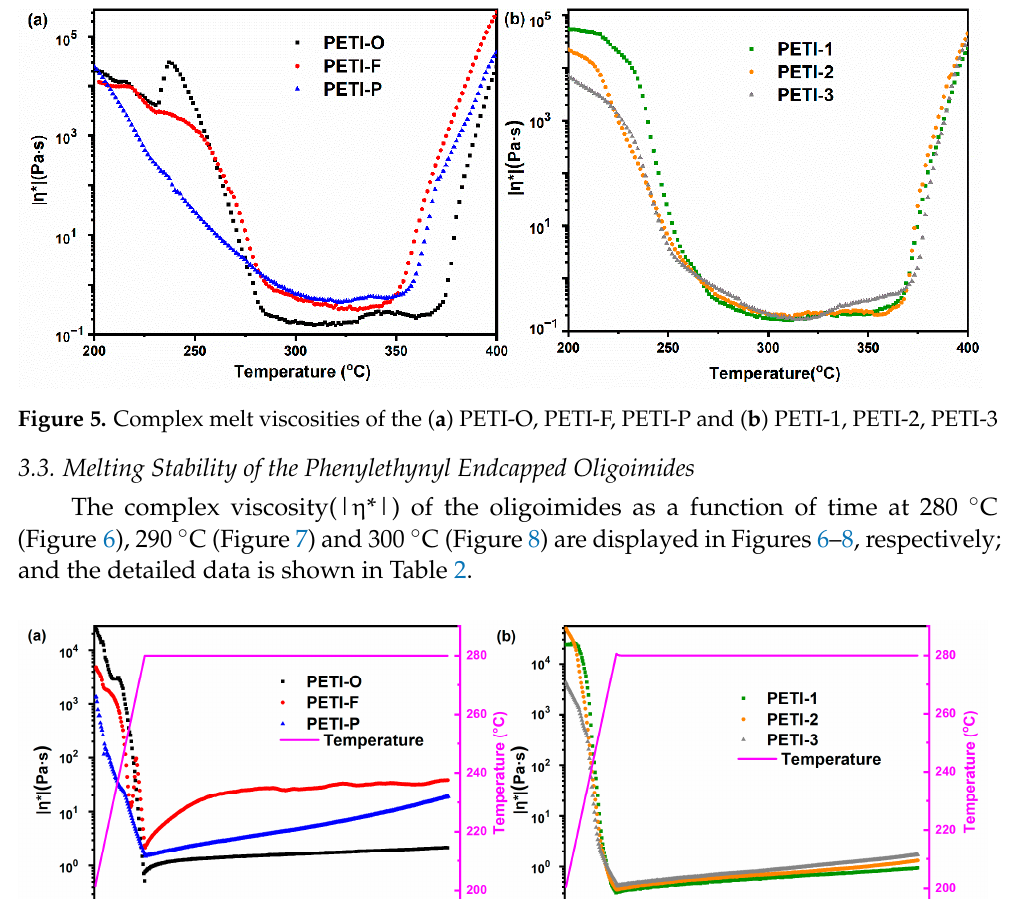
11 of 24 Figure 4. Wide angle X-ray diffraction patterns of ( a ) PETI-O, PETI-F, PETI-P and ( b ) PETI-1, PETI-2, PETI-3. In order to investigate the melting flowing ability of the PEPA end-capped oli- goimides, rheology behaviors of them were characterized, whose detailed results are dis- played in Figure 5 and Table 2. Due to the presence of hexafluoroisopropylidene (– C(CF 3 ) 2 –) units with bulky trifluoromethyl in the backbone, which reduce chain packing or lower the stiffness of polymer chain, all oligoimides are provided with low values of minimum viscosities (min | η *| < 1 Pa·s) [47,48]. All the rheological curves show similar patterns. For instance, with ramping of temperature, the complex viscosity of PETI-O firstly descends significantly. After temperature values grow higher than 280 °C, the vis- cosity values keep low (< 1 Pa·s) until the temperature values reach 375 °C. Then the vis- cosity value ascends significantly due to the crosslinking of phenylethynyl groups. Herein, temperature scale with | η *| < 1 Pa·s ( Δ T | η *| ≤ 1 Pa·s ) is defined as processing temper- ature window for RTM. PETI-O, PETI-F and PETI-P all have low Δ T | η *| ≤ 1 Pa·s of 95 °C, 65 °C and 65 °C, respectively. With the rigid diamine moieties of TFDB and m-PDA contained by PETI-F and PETI-P, they show worse chain movement ability and higher minimum viscosities of 0.31 Pa·s at 331 °C and 0.45 Pa·s at 323 °C. Compared with PETI-P, the lower minimum melt viscosity for PETI-F may be caused by the non-coplanar twist-biphenyl structure of TFDB and increased free volume imparted by –CF 3 groups, which disrupt the chain packing and decrease the interactions between the oligoimide chains for PETI-F